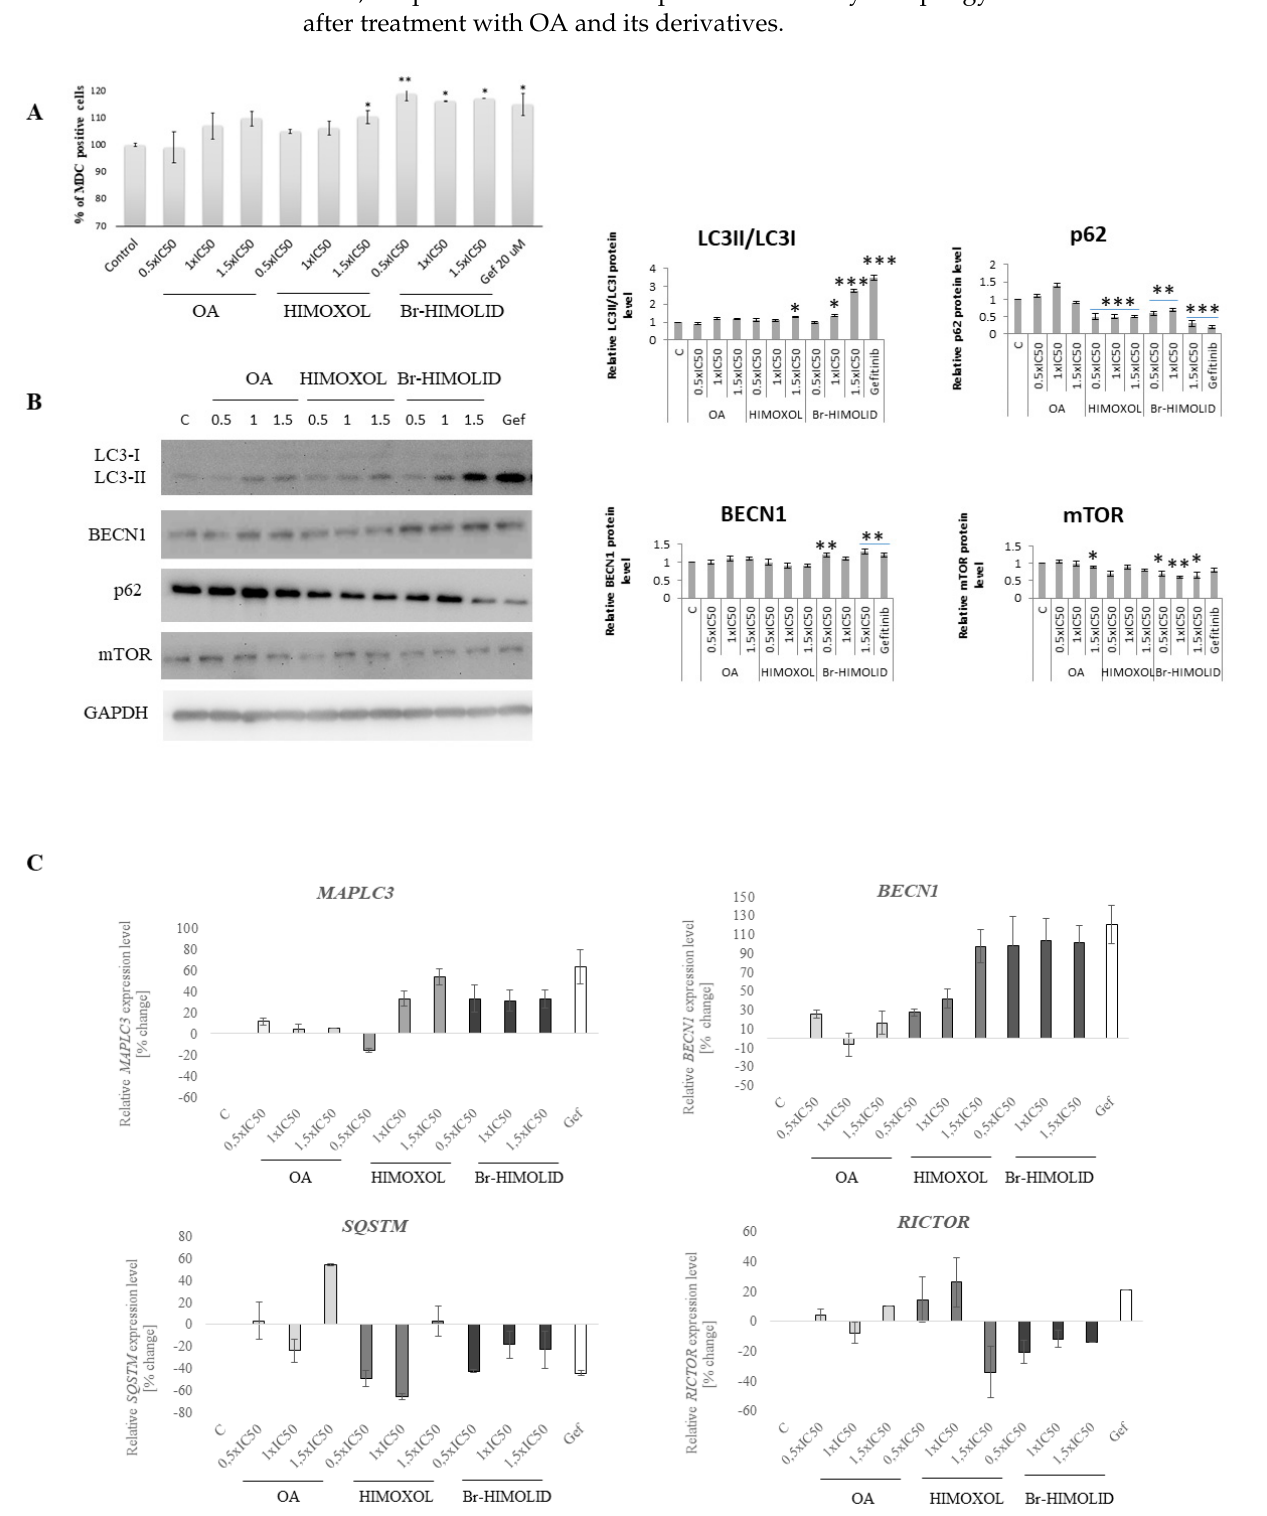
Figure 6. Evaluation of autophagy induction by OA and its derivatives. SK-BR-3 cells were treated with studied compounds, i.e., 0.5 × 1 × or 1.5 × IC 50 respective values were applied followed by monodansylcadaverine (MDC) staining (mean fluorescence, MFI, detection) and immunodetection. ( A ) Bars represent relative MFI of MDC staining in the indicated samples versus corresponding controls; B, immunoidentification of target proteins was subjected to densitometry analysis normalized to GAPDH. Gefitinib (Gef, 20 µM) was used as a positive control. The mean of three independent experiments is shown with p < 0.05 calculated from paired data. × ± SD, p < 0.05 ( B ). Statistically significant difference versus control samples is shown: * p < 0.05; ** p < 0.005; *** p < 0.001. ( C ) Evaluation of autophagy induction by OA and its derivatives in